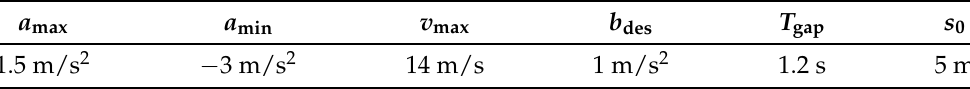
Table 1. The simulation parameters